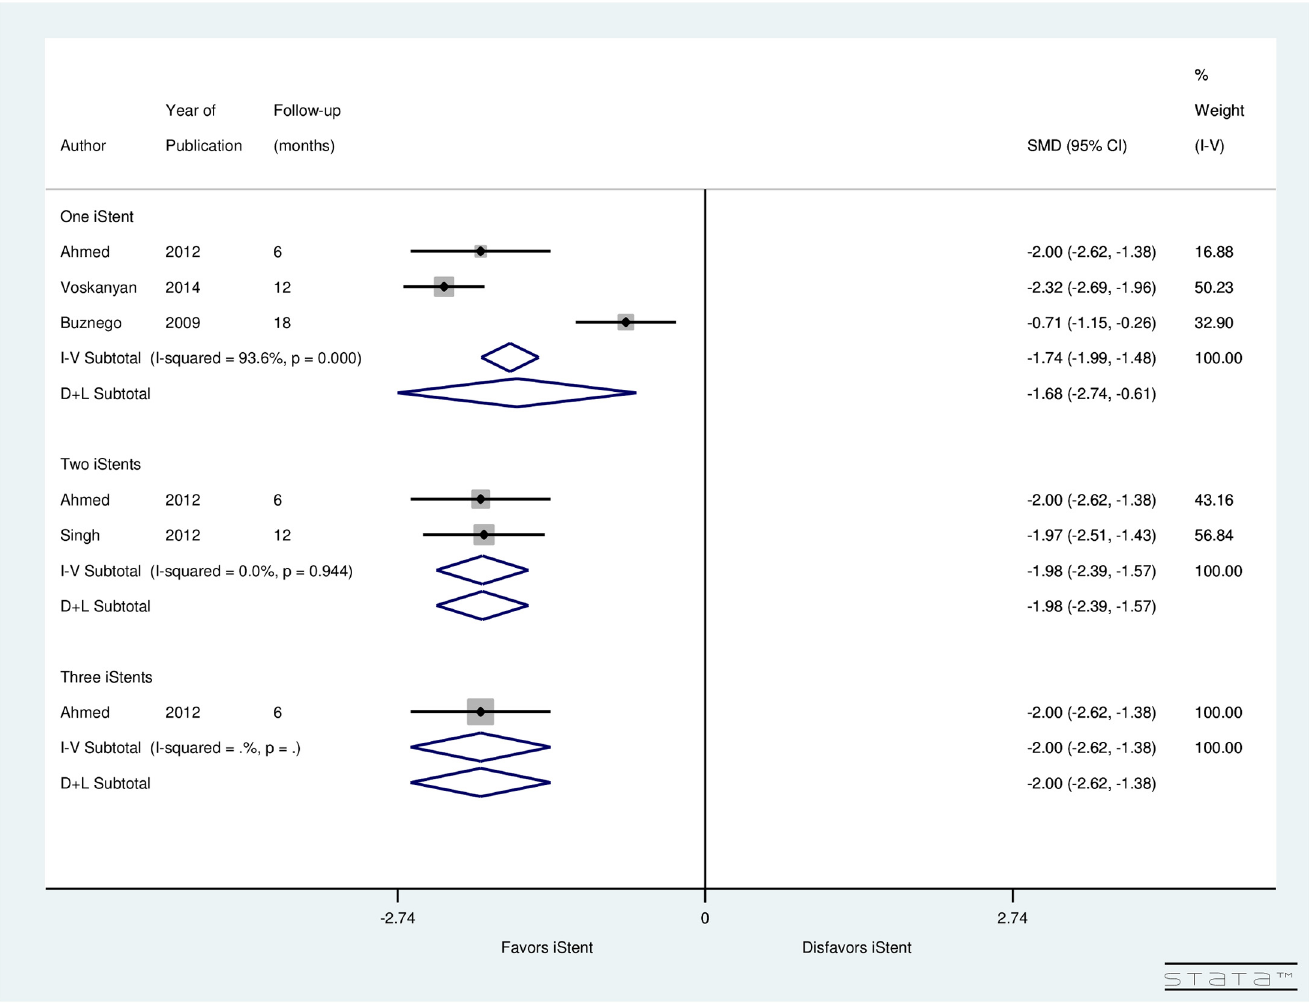
Fig 8. Forest plot for pre- and post-operative number of medications by number of iStents